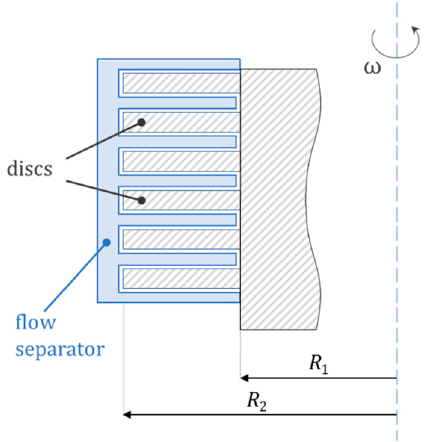
Figure 4. Flow separator—cross section A-A.